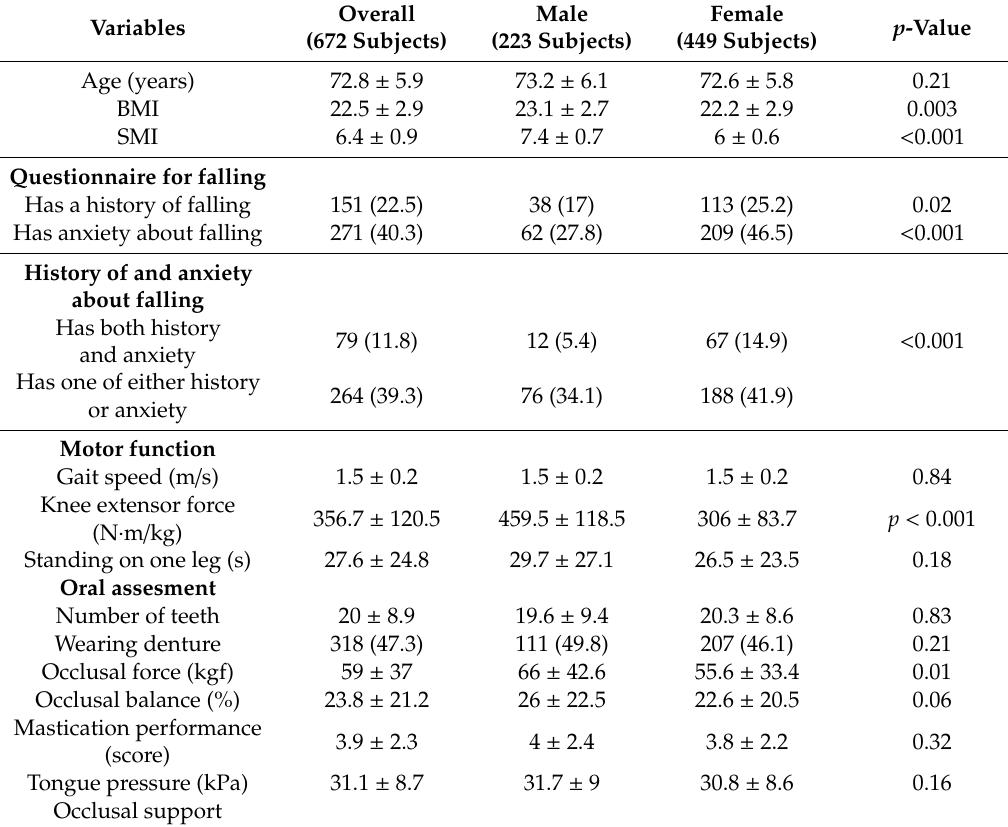
Table 1. Subject